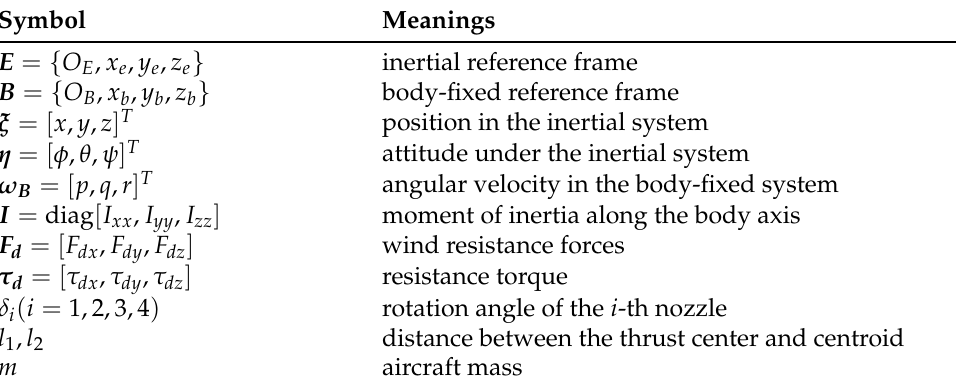
Table 4. Meanings of